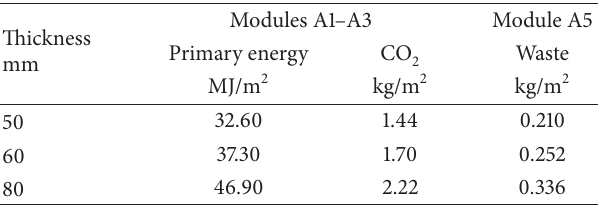
Table 3: Environmental information of the glass wool panel used in the research